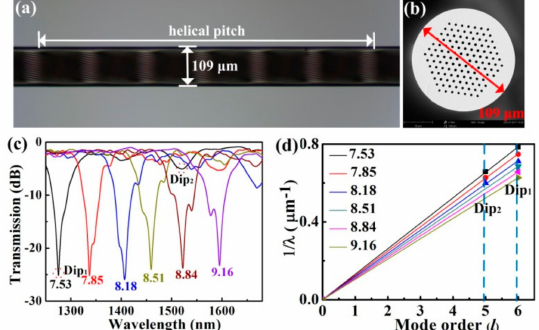
Figure 15. ( a ) Side-view and ( b ) cross-section microscope images of the HLPFG in PCF; ( c ) transmission spectra of six HLPFG samples with di ff erent twist rates; ( d ) reciprocal resonant wavelength ( λ R ) in units of at µ m − 1 plotted against mode order for the experimental data [14].